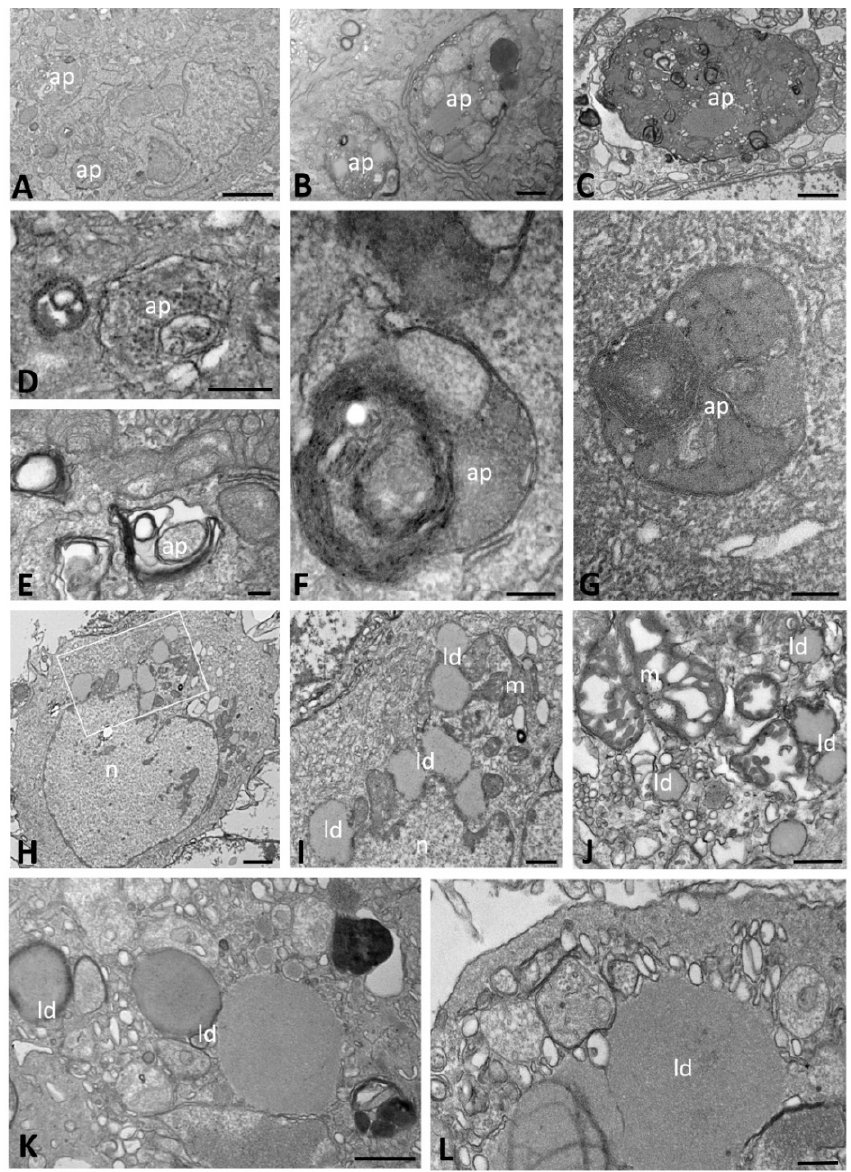
Figure 6. Transmission electron microscopy showing autophagosome structures ( A – G ) and lipid droplets ( H – L ) in SARS-CoV-2-infected CFBE41o- Δ F cells. Autophagosomes are visible at early ( A – C ) and late times of infection ( D – G ). In ( G ), the sample was treated with tannic acid. The boxed area in ( H ) is enlarged in ( I ). (ap): autophagosome; (ld): lipid droplet; (m): mitochondria; (n): nucleus. Bars: ( A ) 2 µm; ( C , H ) 1 µm; ( B , I – K ) 500 nm; ( D , L ) 200 nm; ( E – G ) 100 nm.